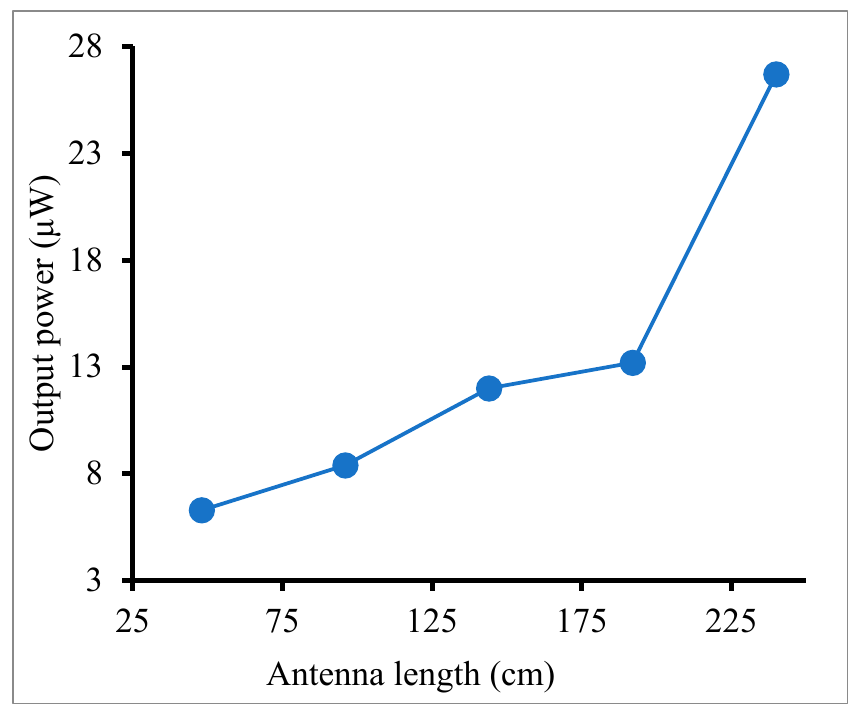
Figure 9. Output power with length of antenna. Other parameters were constant. Speed of air was around 3.5 m/s, and wire diameter was 3.0 mm. All other parameters were similar to those in Figure 8.